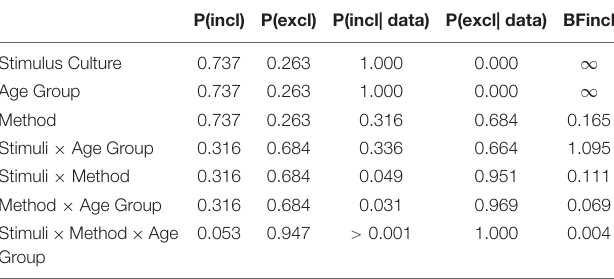
TABLE 2 | Evidence for the presence of particular effects in the accuracy of the auditory task (Data averaged over all the models including/excluding a particular predictor).